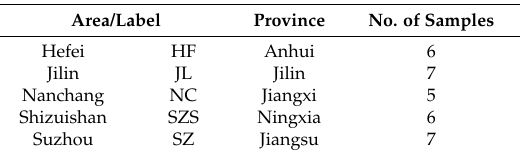
Table 1. Geographical information of 31 rice grains samples.